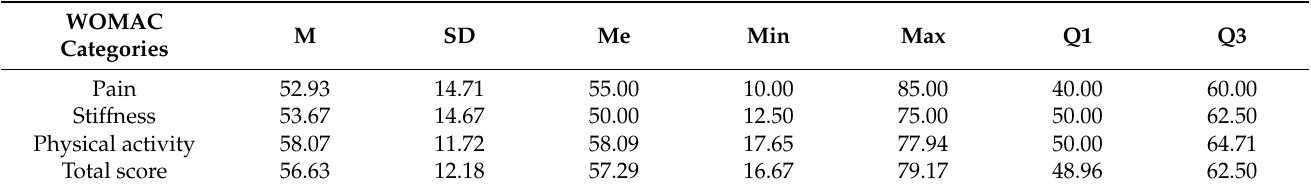
Table 5. The results of the assessment of pain, stiffness, functional activity and the level of disability in group of patients with